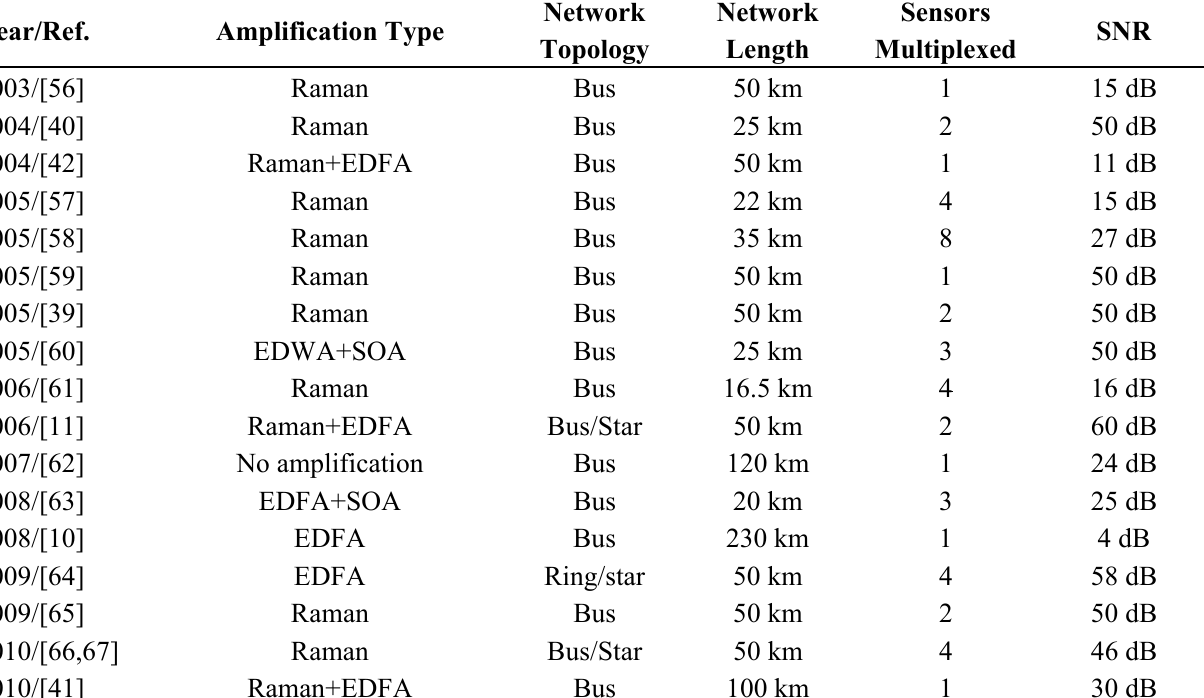
Table 1. State of the art of remote fiber-optic sensor